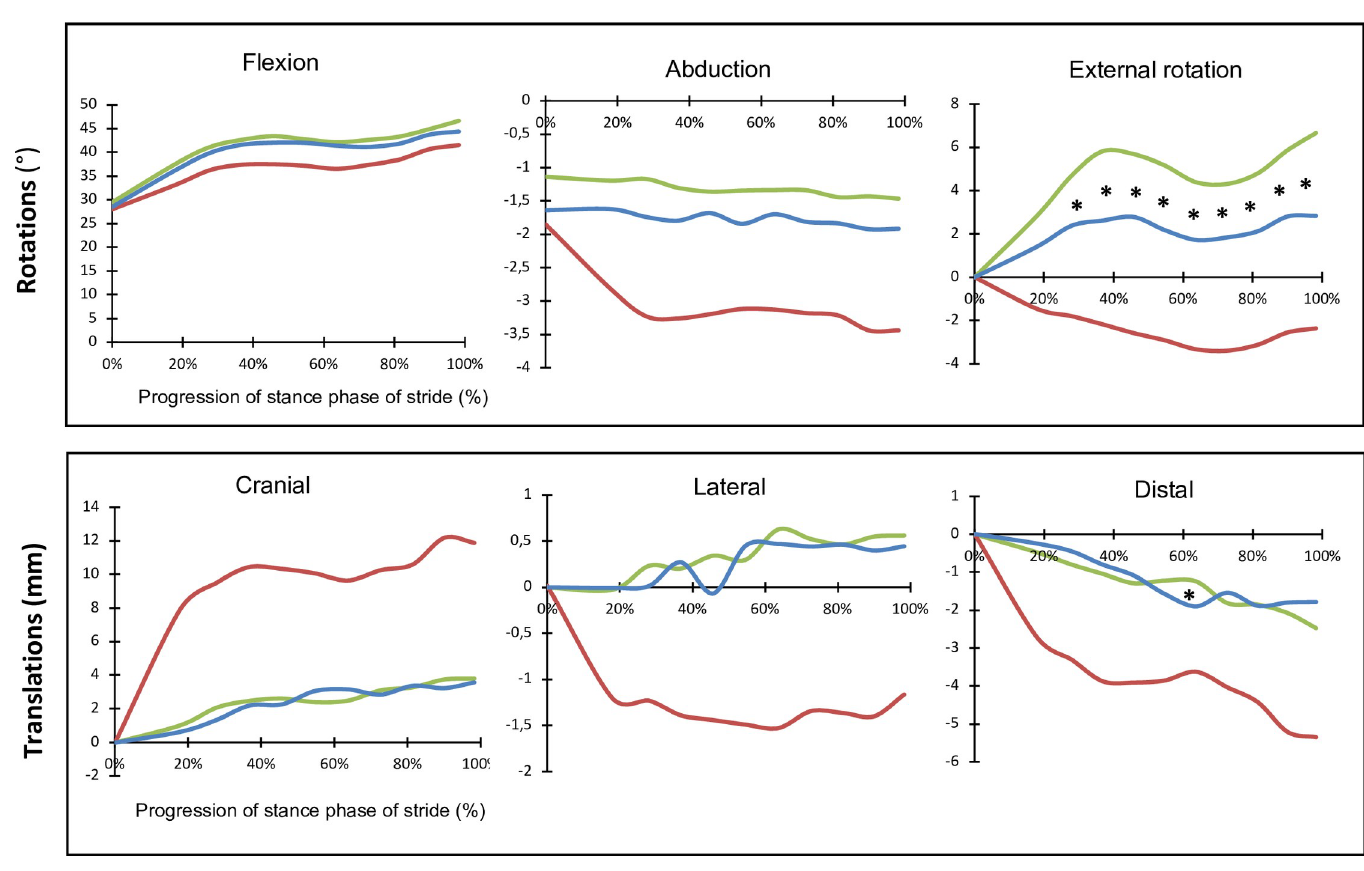
Fig 2. Three-dimensional kinematics for intact (green), cranial cruciate ligament deficient (red) and lateral suture stabilized (blue) stifles through the stance phase of stride. Curves represent the mean values for 10 stifles through 5 cycles each. � Statistically significant difference (using Wilcoxon signed-rank test) at that time point between intact and stabilized